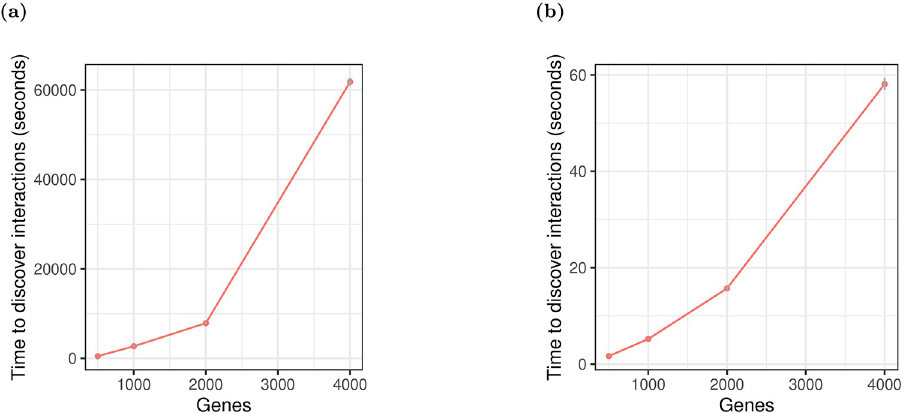
Fig 11. Run time in seconds to find interactions on increasingly large data set. (a) glinternet . (b) xyz . We compiled glinternet with OpenMP and ran with numCores = 10